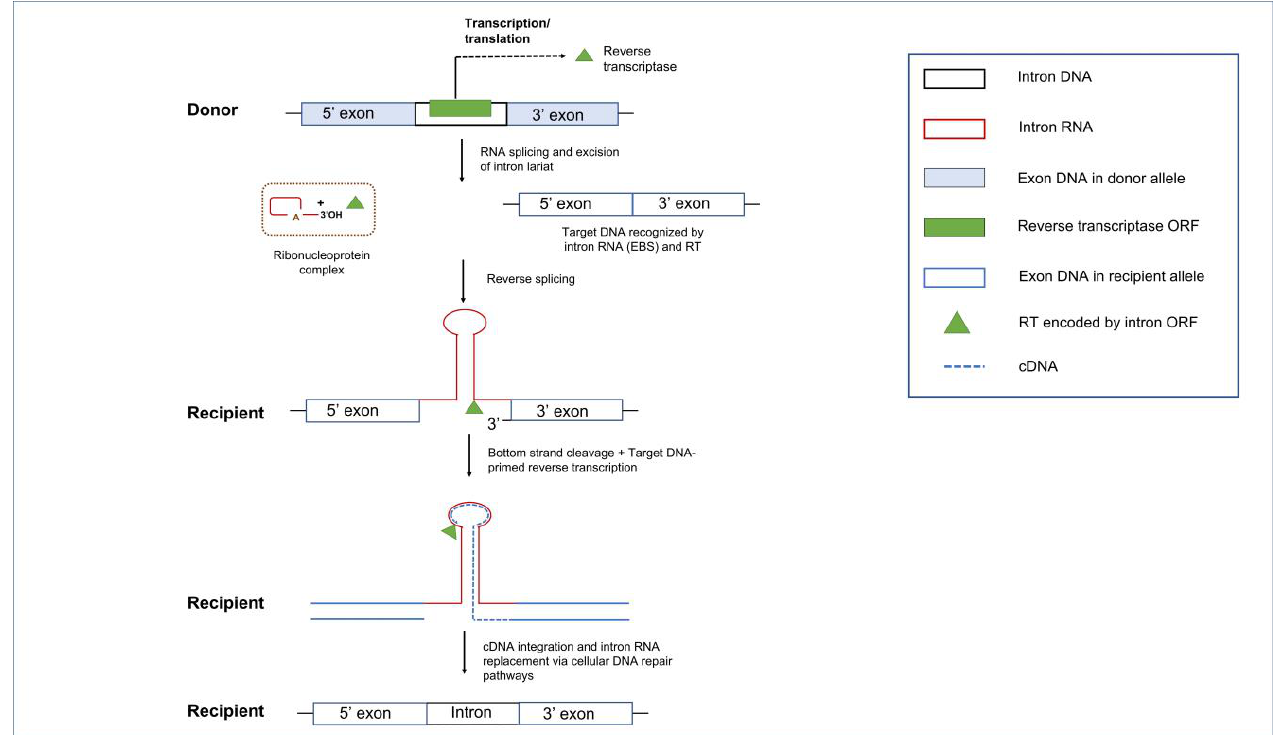
Figure 6. Mobility pathway of Group II introns through retrohoming. Intron retrohoming is mediated by the multi-functional reverse transcriptases (RT, green triangle) encoded by the RT-ORF (green box) in the intron-containing donor allele. The RT protein binds to the intron resulting in a ribonucleoprotein (RNP) complex (brown dashed box) containing the excised intron lariat RNA (red) and the tightly bound RT. RNPs recognize the DNA target by using both the RT (DNA binding domain) and base-pairing of the intron RNA (via the EBS) and then promotes reverse splicing of the intron RNA into the top strand of the dsDNA. After reverse splicing, the bottom DNA strand at the target site is cleaved by the endonuclease domain of the RT. The 3′ end generated at the cleavage site is used as a primer for target DNA-primed reverse transcription of the inserted intron RNA. The original intron RNA (inserted in the sense or top strand) and the resulting intron RNA derived cDNA (blue dashed line) will be integrated into the host genome by the host DNA recombination or repair mechanisms.